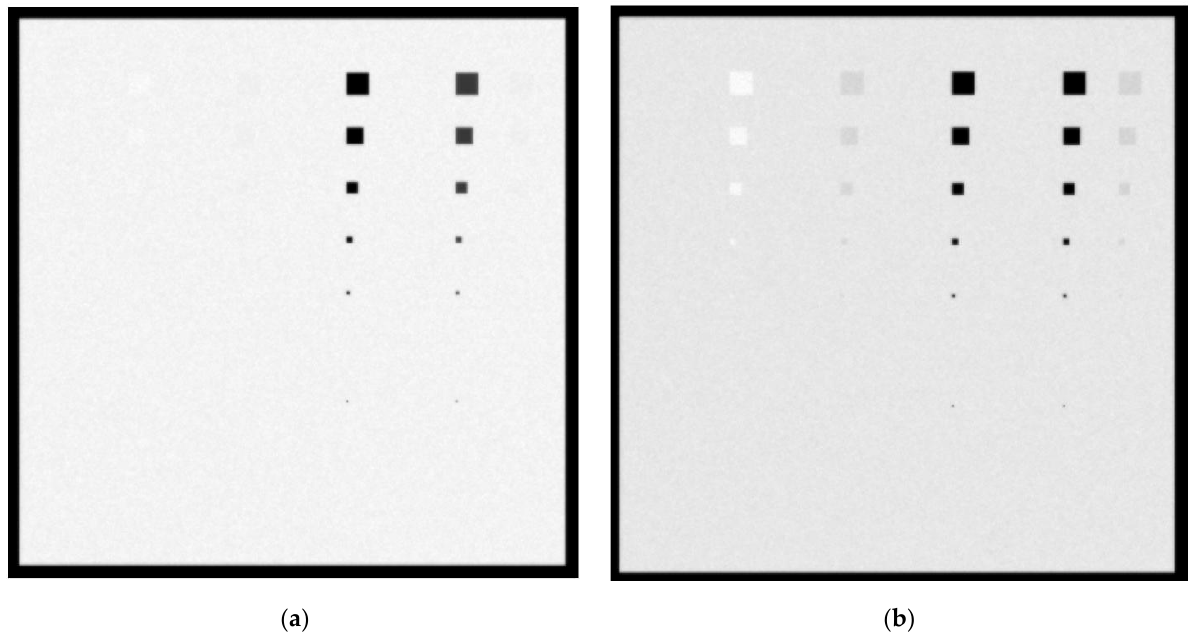
Figure 7. A 4.2 cm phantom image for W/Rh 5 mGy and 28 kVp spectrum with ( a ) 0.1 cm lesion thickness and ( b ) 0.5 cm lesion thickness.